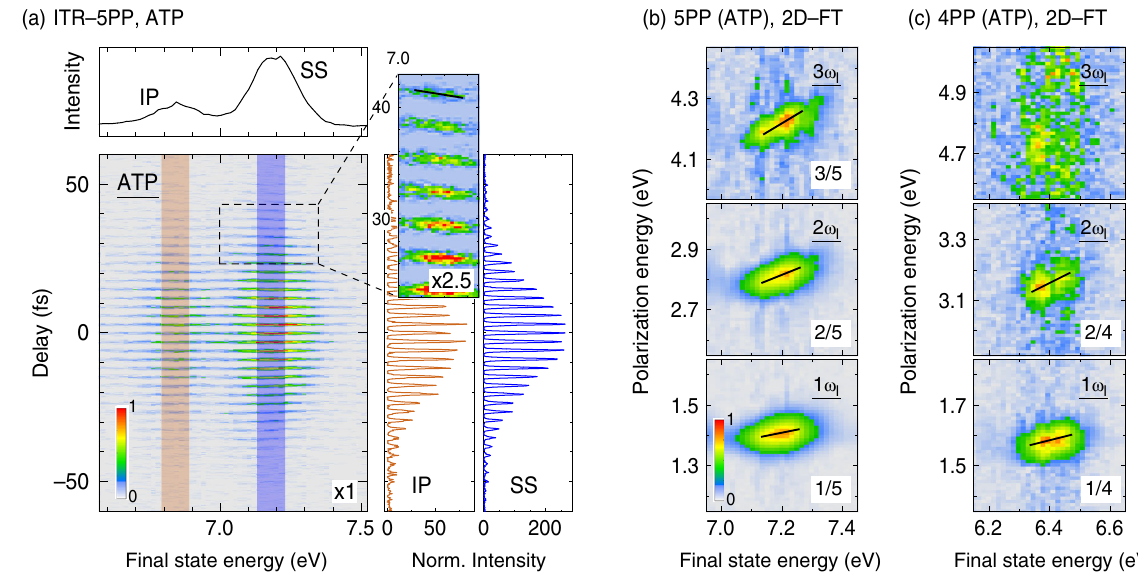
FIG. 9. (a) ITR-mPP experiment for the ATP component of the first IP and SS states that are excited in a m ¼ ð 4 þ 1 Þ -photon process ( ℏ ω l ¼ 1 . 40 eV, k k ¼ 0 ). The data are taken from the same experiment as shown in Fig. 6. Left bottom: Color-coded photoelectron counts as a function of the pump-probe delay and final state energy. Top: Energy profile taken for t ¼ 0 fs. Right: The cross sections (I2PC scans) of the SS and IP states show a high peak-to-baseline ratio as expected for a fifth-order process. Inset: Tilting of the fringes is highlighted by the black line at t ≈ 41 fs. (b) Components of 2D-FT photoelectron spectra of the SS state excited in a m ¼ ð 4 þ 1 Þ - photon ATP process [FTof the data in (a)]. The FT amplitude is observed for 0 ω l (not shown), 1 ω l , 2 ω l , and 3 ω l ; the slopes are marked with black lines and quantified in the white boxes. (c) Components of 2D-FT photoelectron spectra of the SS state excited in the m ¼ ð 3 þ 1 Þ -photon ATP process ( ℏ ω ¼ 1 . 60 eV, k ¼ 0 ); tilted FTamplitude is evident for 0 ω 1 ω 2 ω l k l (not shown), l , and l as marked with black lines and quantified in the white boxes. The color range of each 2D spectra is scaled